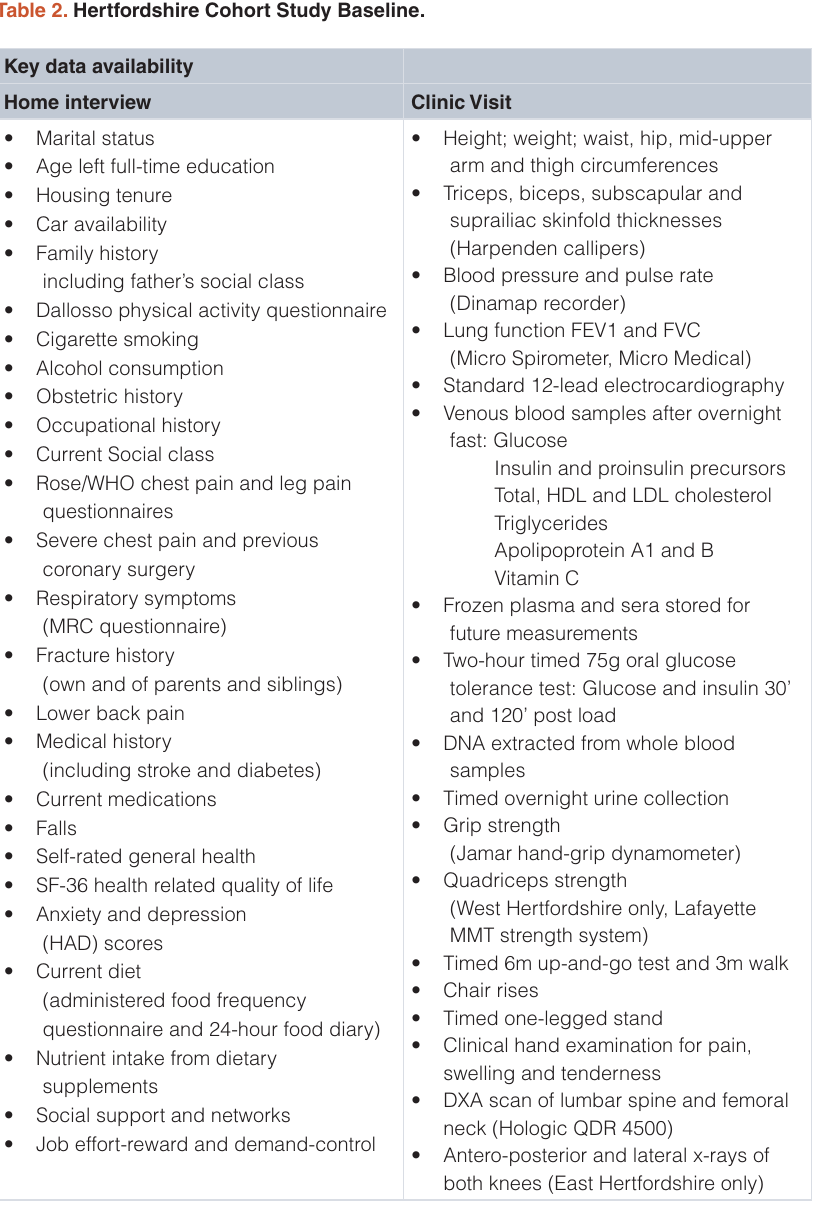
Table 2. Hertfordshire Cohort Study